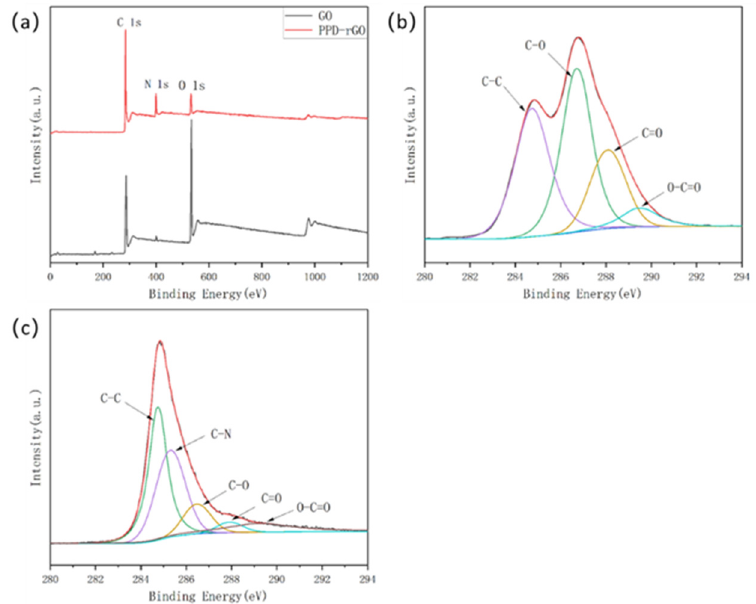
Figure 4. XPS spectra of GO and PPD-rGO. ( a ) Full spectrum; ( b ) C 1s spectrum of GO; ( c ) C 1s spectrum of PPD-rGO.